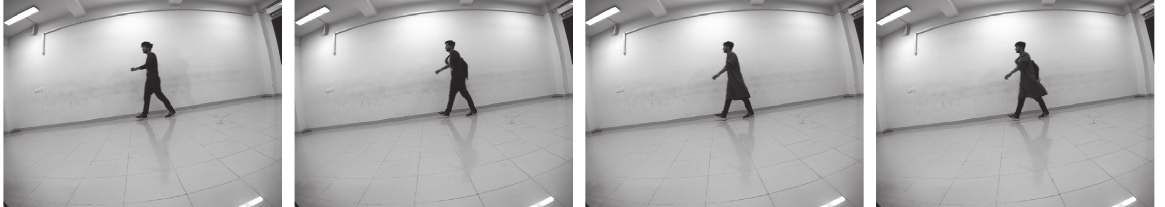
Figure 3: The male subject of the SACV-Gait dataset in different appearance.